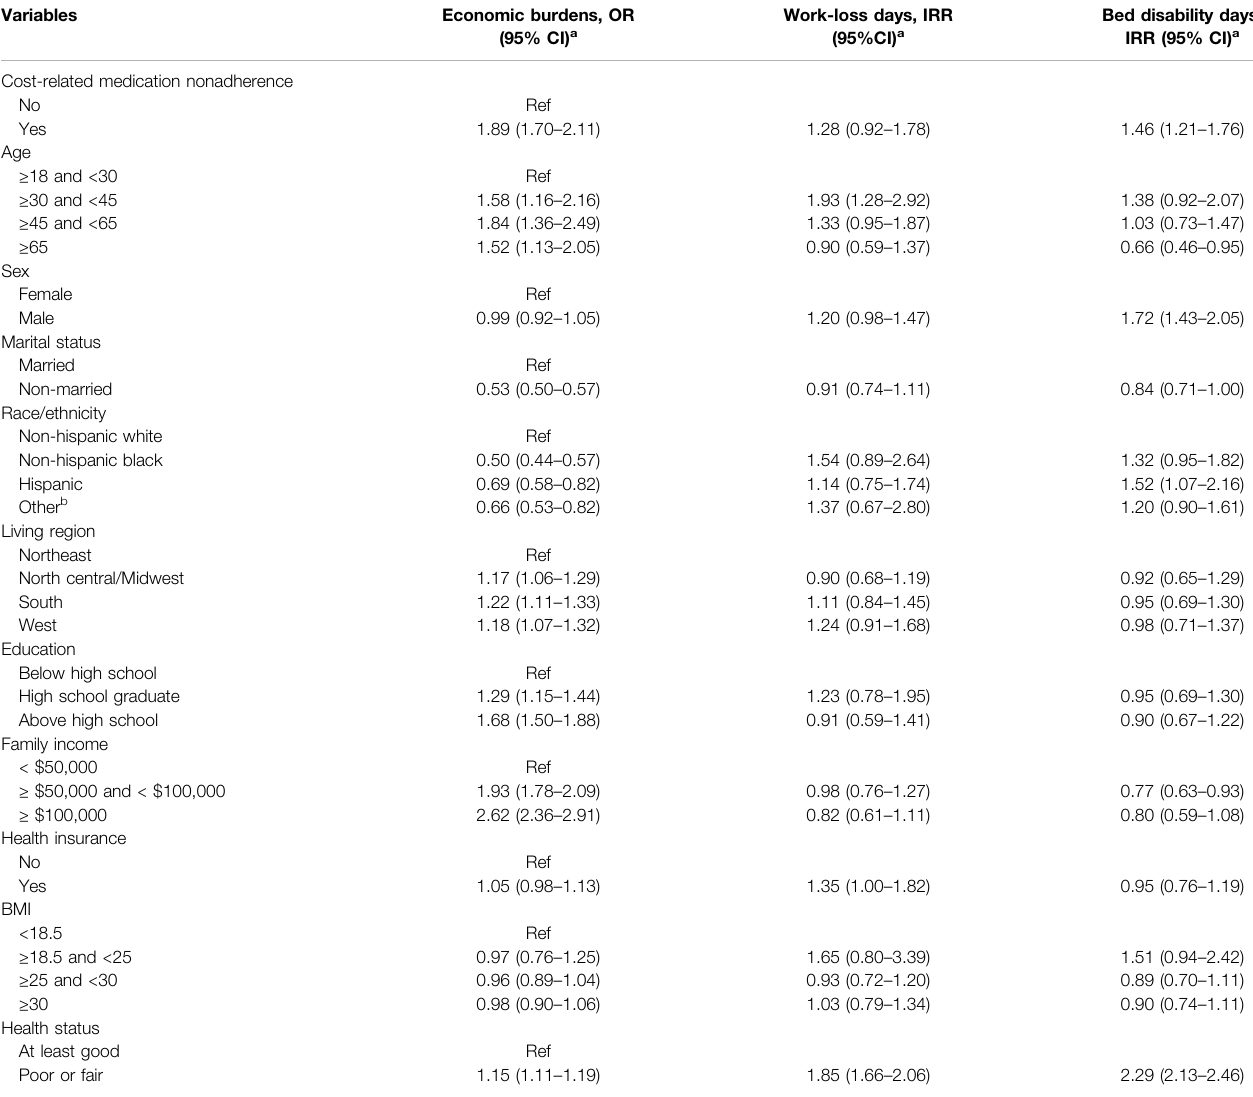
TABLE 2 | The impact of cost-related medication nonadherence on economic burdens and productivity loss among cancer survivors.